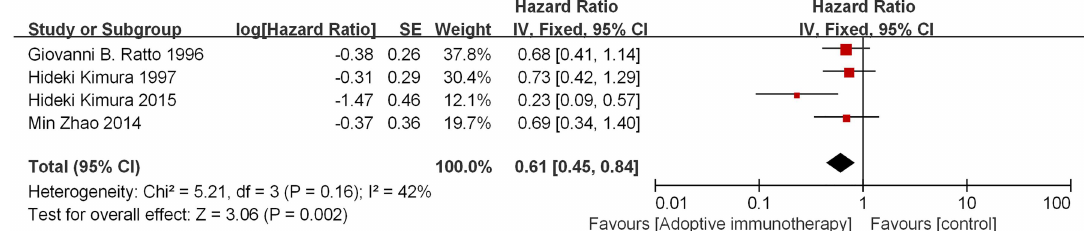
Fig 3. Forestplotof hazard ratio(HR)of overall survivalin AI group versus control